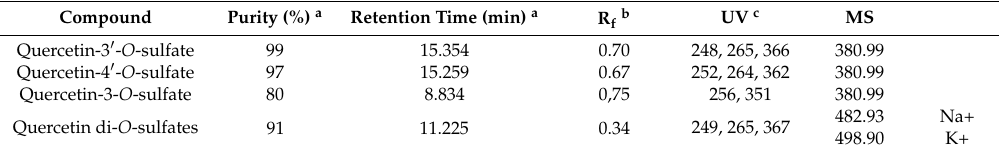
Table 3. Quercetin sulfates obtained using arylsulfatase: analytical characteristics.